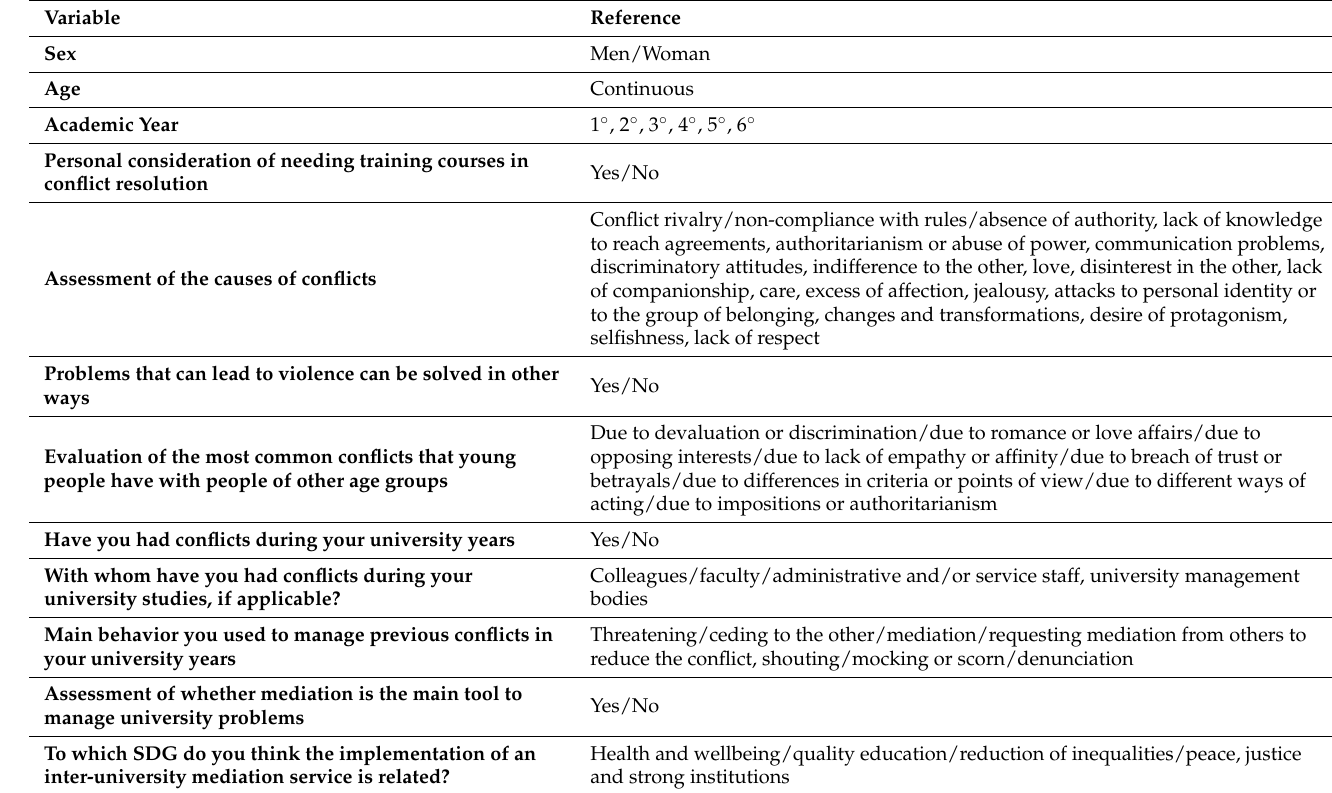
Table 1. Socio-demographic profile and descriptive study